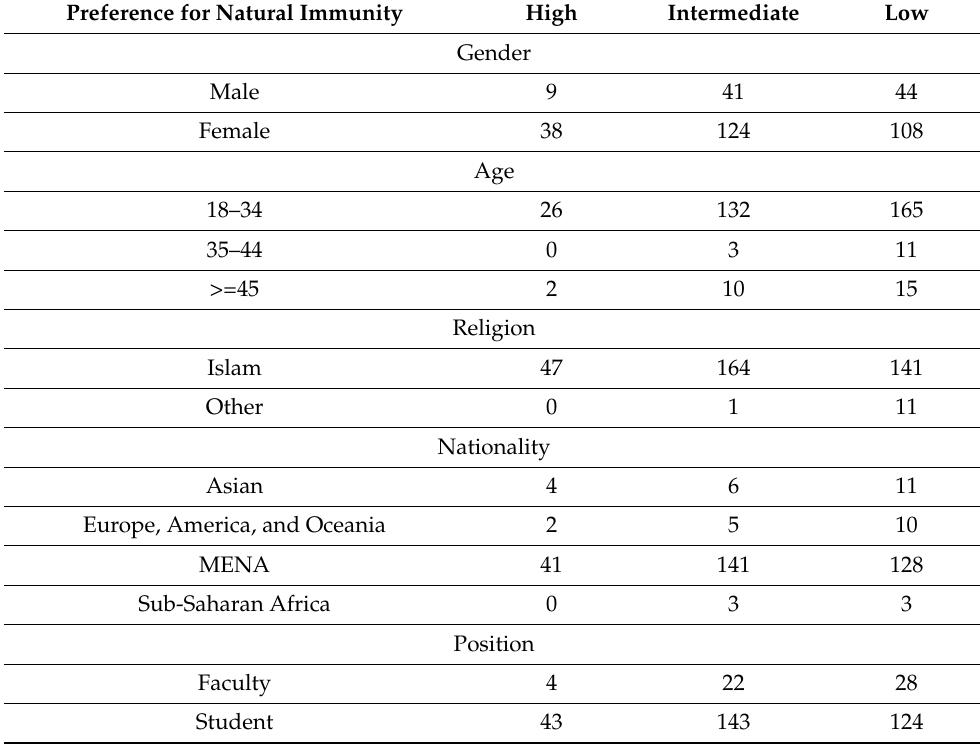
Table A5. Actual number of participants in Preference for Natural Immunity